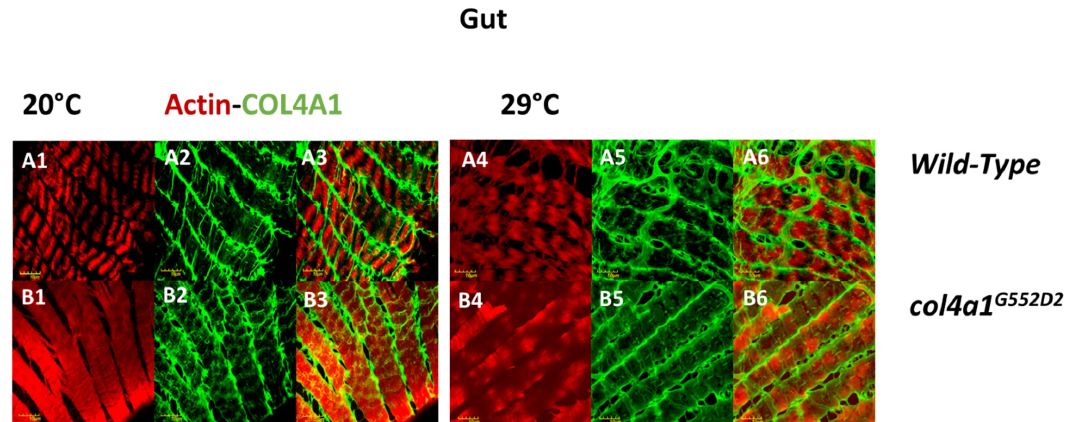
Figure 4. Loss of sarcomere structure in visceral muscle fibers. Regular sarcomere structure in the wild-type control at both temperatures (A1, A4) and loss of sarcomeres in the mutant that deposits actin in an irregular fashion (B1, B4). Bars, lower left: 10 micrometers. Experiments were carried out as described